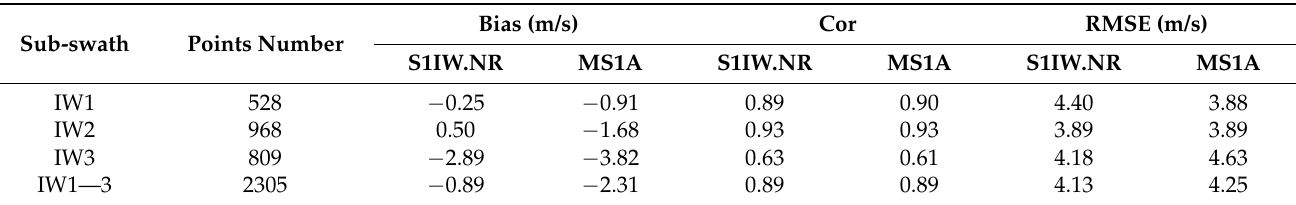
Table 3. Validation results of the proposed S1IW.NR model with the SFMR wind speed references and comparison with the MS1A model based on Dataset